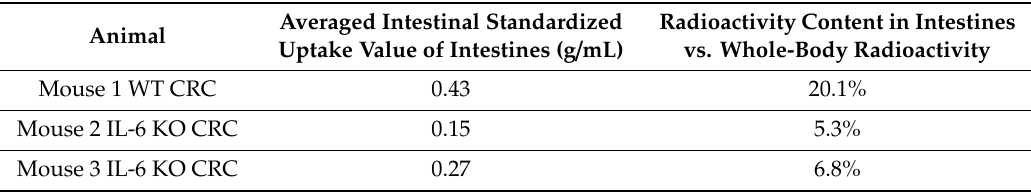
Table 1. PET FDG-uptake di ff erences. PET FDG-uptake di ff erences in the intestinal volume of interest containing tumorous foci in imaged mice.